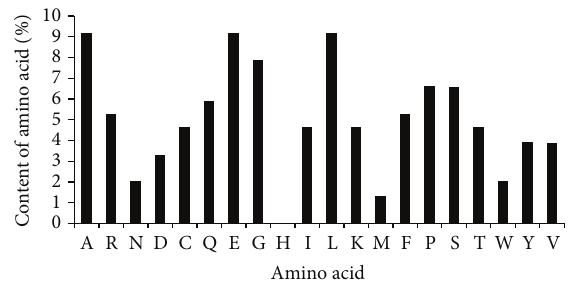
Figure 1: Amino acid composition of human IL-38